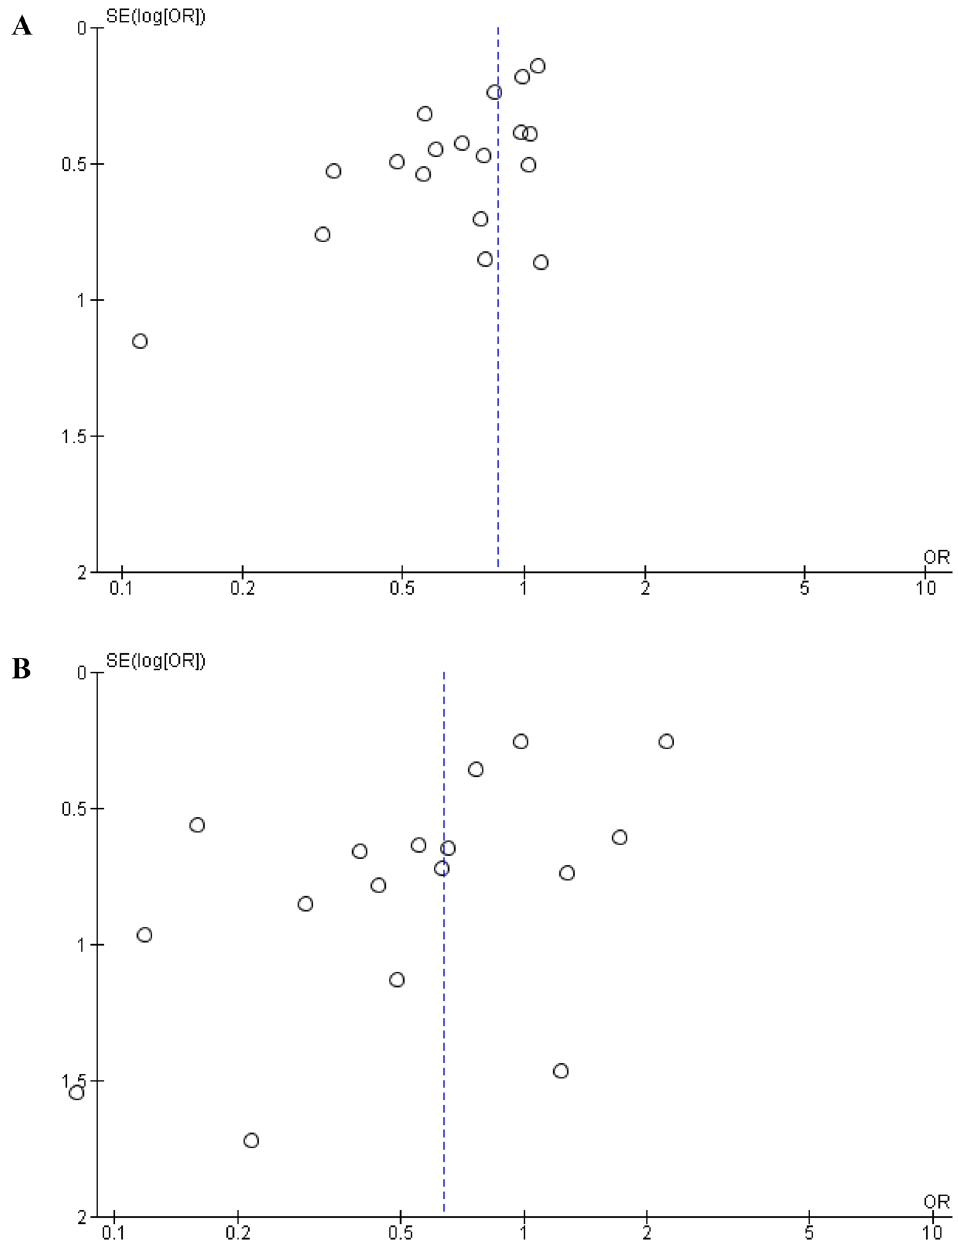
Figure 7. Funnel plot of reporting bias: ( A ) Overall postoperative morbidity. ( B ) Resection margin involvement